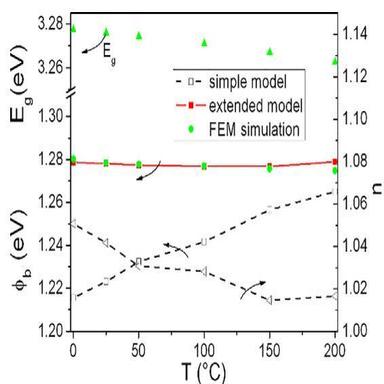
(a) Schottky barrier height /b and ideality factor n extracted by simple and extended model compared with FEM simulation.